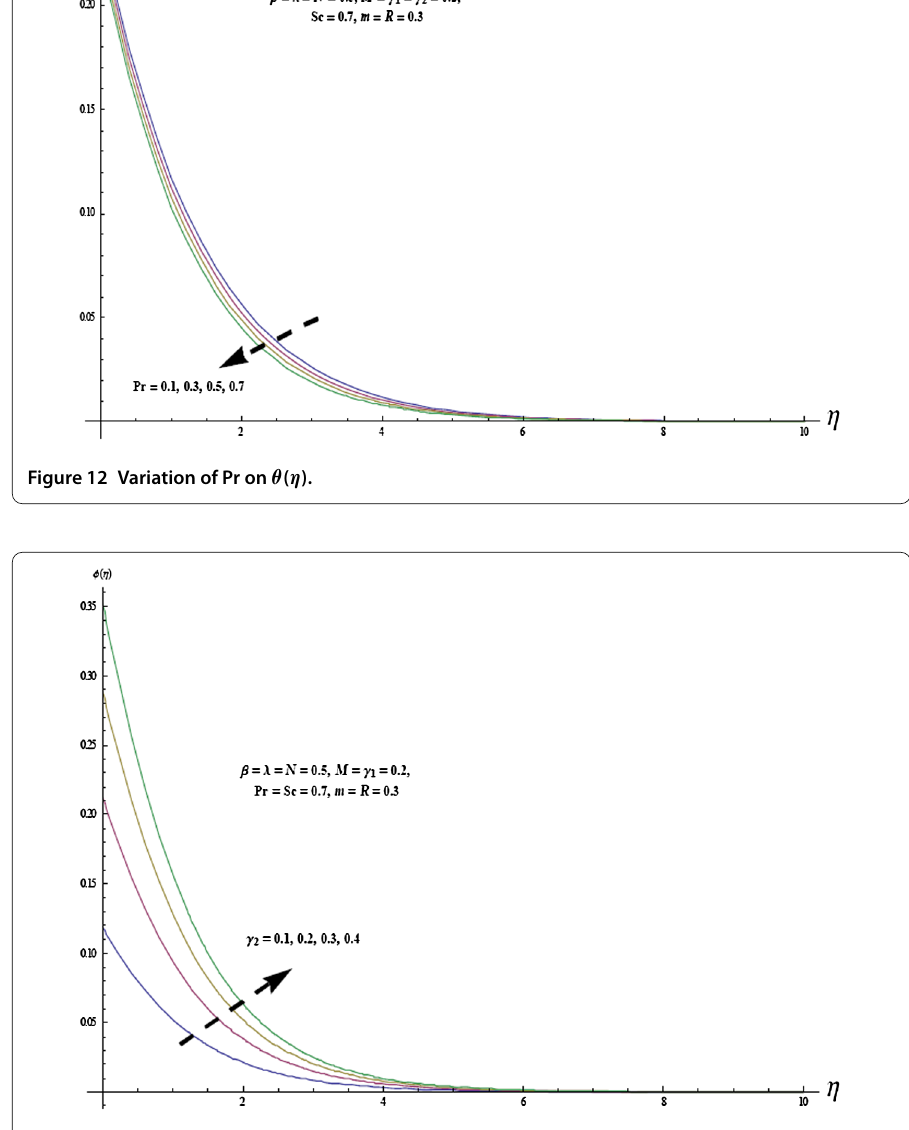
Figure 13 Variation of γ 2 on ϕ ( η